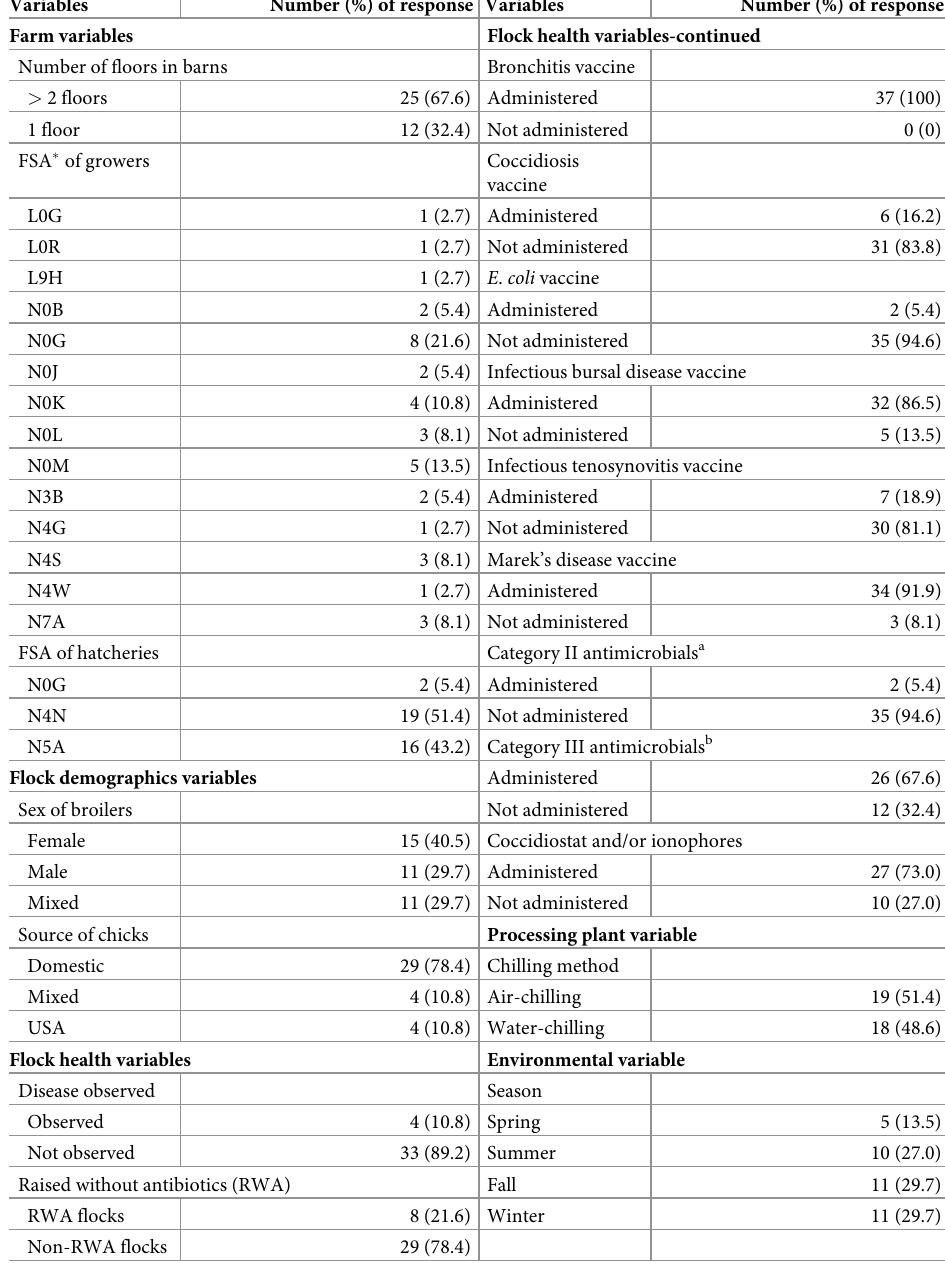
Table 3. Descriptive statistics of 18 categorical variables from 37 chicken broiler flocks surveyed in a study on the occurrence of breast myopathies in Ontario, Canada